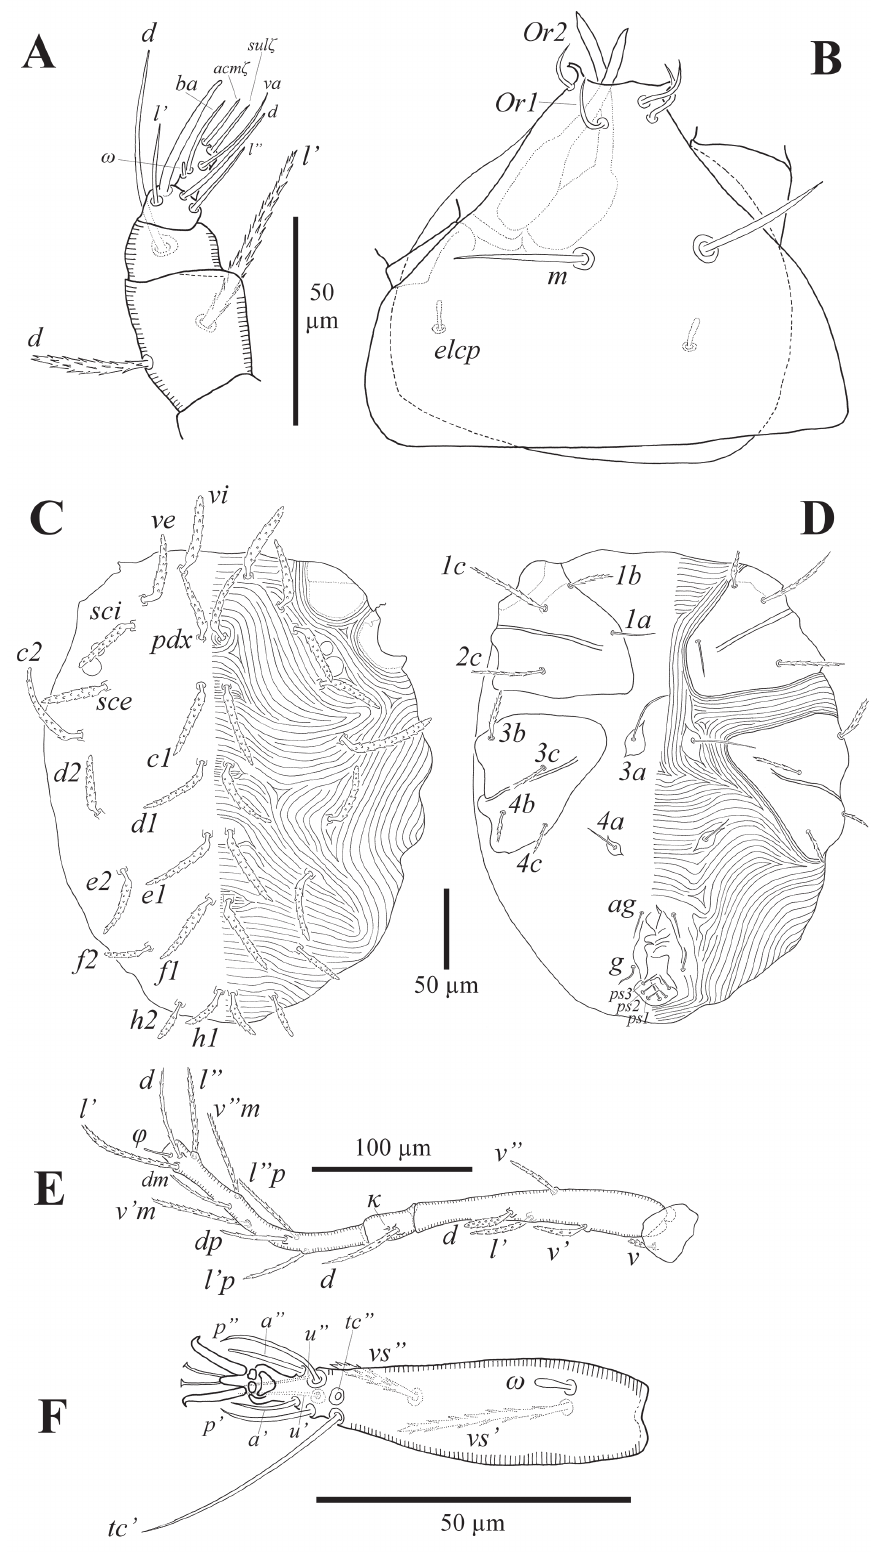
Fig. 5. Neophyllobius tepoztlanensis sp. nov., ♀, holotype. A . Palp. B . Subcapitulum. C . Dorsal idiosoma. D . Ventral idiosoma. E . Trochanter–tibia of leg I. F . Tarsus